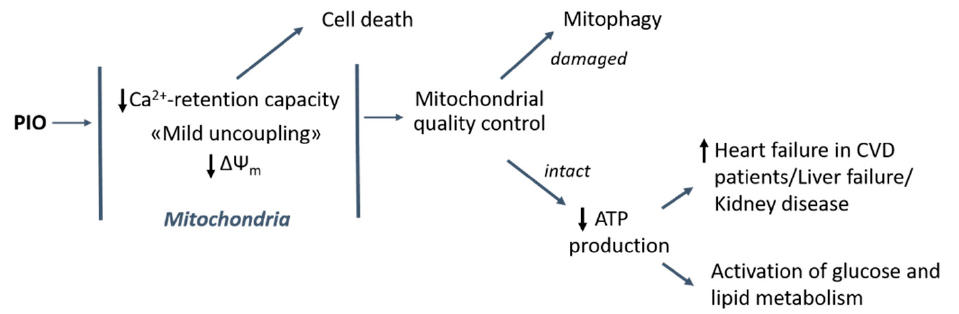
Figure 8. Contribution of uncoupling and mPTP-modulating effects of PIO to its healing and harmful action in the cell and the organism. CVD: cardiovascular disease.